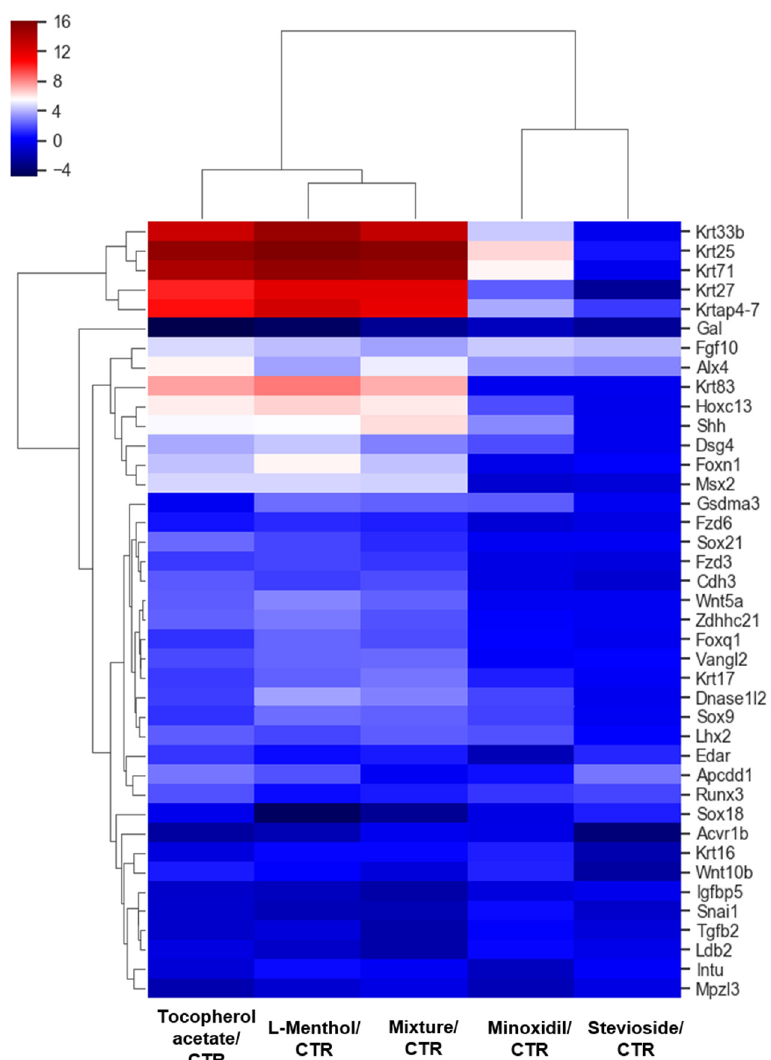
Figure 4. Heat map of gene expression levels for tocopherol acetate vs. CTR, L-menthol vs. CTR, L-menthol + tocopherol acetate + stevioside vs. CTR, minoxidil vs. CTR, and stevioside vs. CTR. Significant genes were defined as those with a 3-fold change, normalized data of 5.00, and p -value < 0.05. Hierarchical clustering was performed in the functional category of hair growth. CTR = control